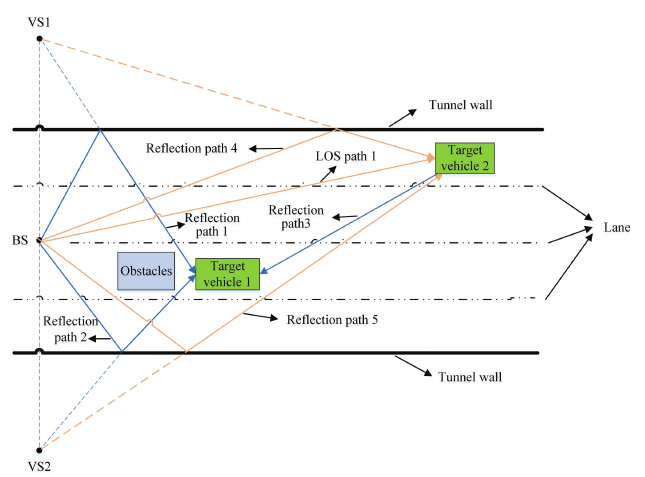
Figure 3. The cooperative vehicle positioning is based on reflecting paths from tunnel walls and surrounding